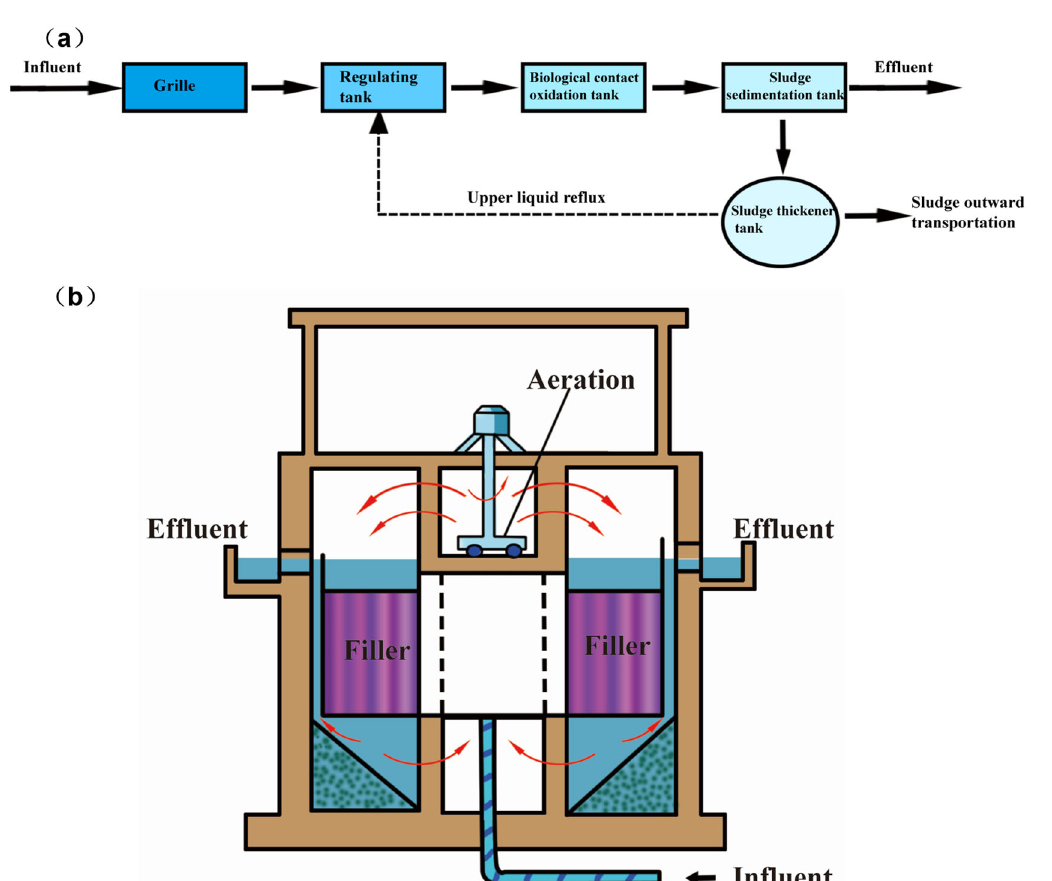
Figure 3. Biological contact oxidation process flow ( a ) and schematic diagram of the schematic diagram tank ( b ).